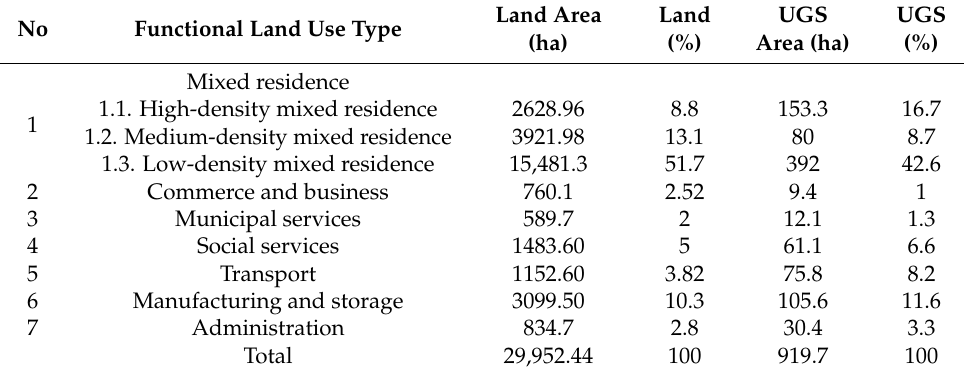
Table 6. Functional land use and urban green space proportions in Addis